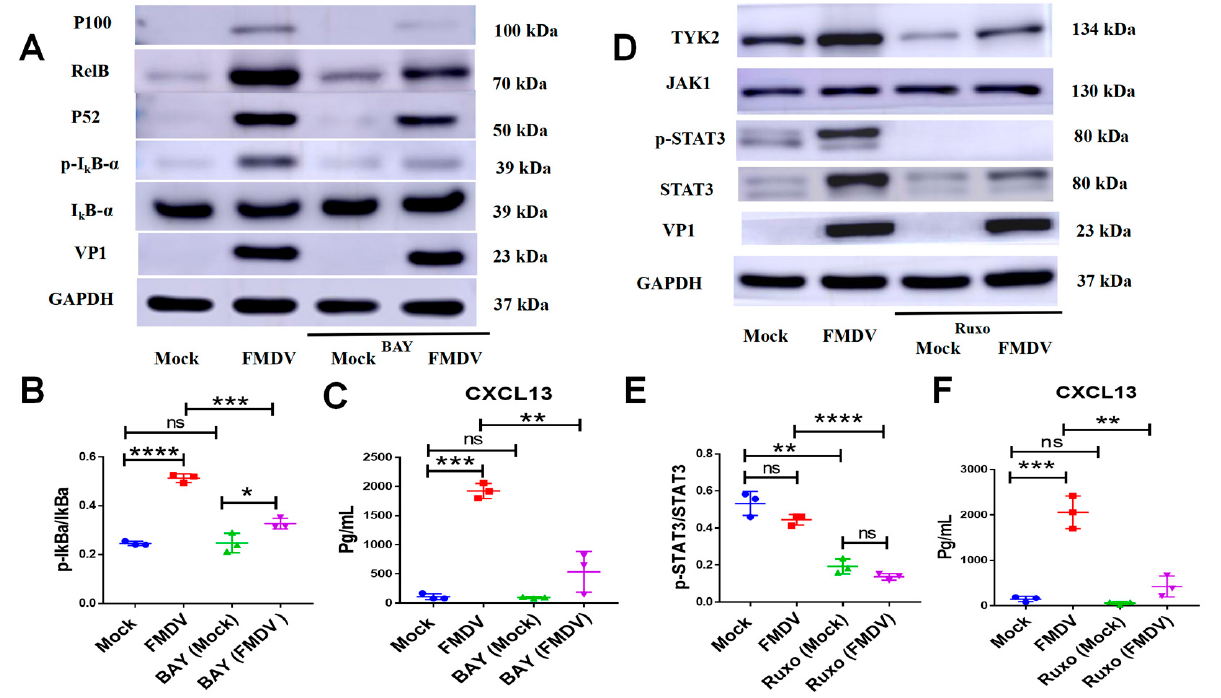
Figure 5. FMDV induces CXCL13 production in BMDMs by activating NF- κ B and JAK/STAT signaling pathways. ( A ) The expressions of VP1, I κ Ba, p-I κ Ba, P100, P52, RelB and glyceraldehyde-3- phosphate dehydrogenase (GAPDH) in cell lysates of BMDMs, BMDMs infected with FMDV, BMDMs treated by BAY at the recommended concentration of 10 µ M, and BMDMs treated by BAY and FMDV were analyzed in by Western blotting. ( B ) The gray value ratio of p-I κ Ba/I κ Ba in BMDMs under different conditions of BAY treatment and FMDV infection. ( C ) The CXCL13 concentrations of the supernatant from BMDMs under different conditions of BAY treatment and FMDV infection were measured by ELISA. ( D ) The expressions of VP1, STAT3, p-STAT3, JAK1, TYK2 and GAPDH in cell lysates of BMDMs, BMDMs infected with FMDV, BMDMs treated by ruxolitinib at the recommended concentration of 10 µ M, and BMDMs treated by ruxolitinib and FMDV were analyzed by